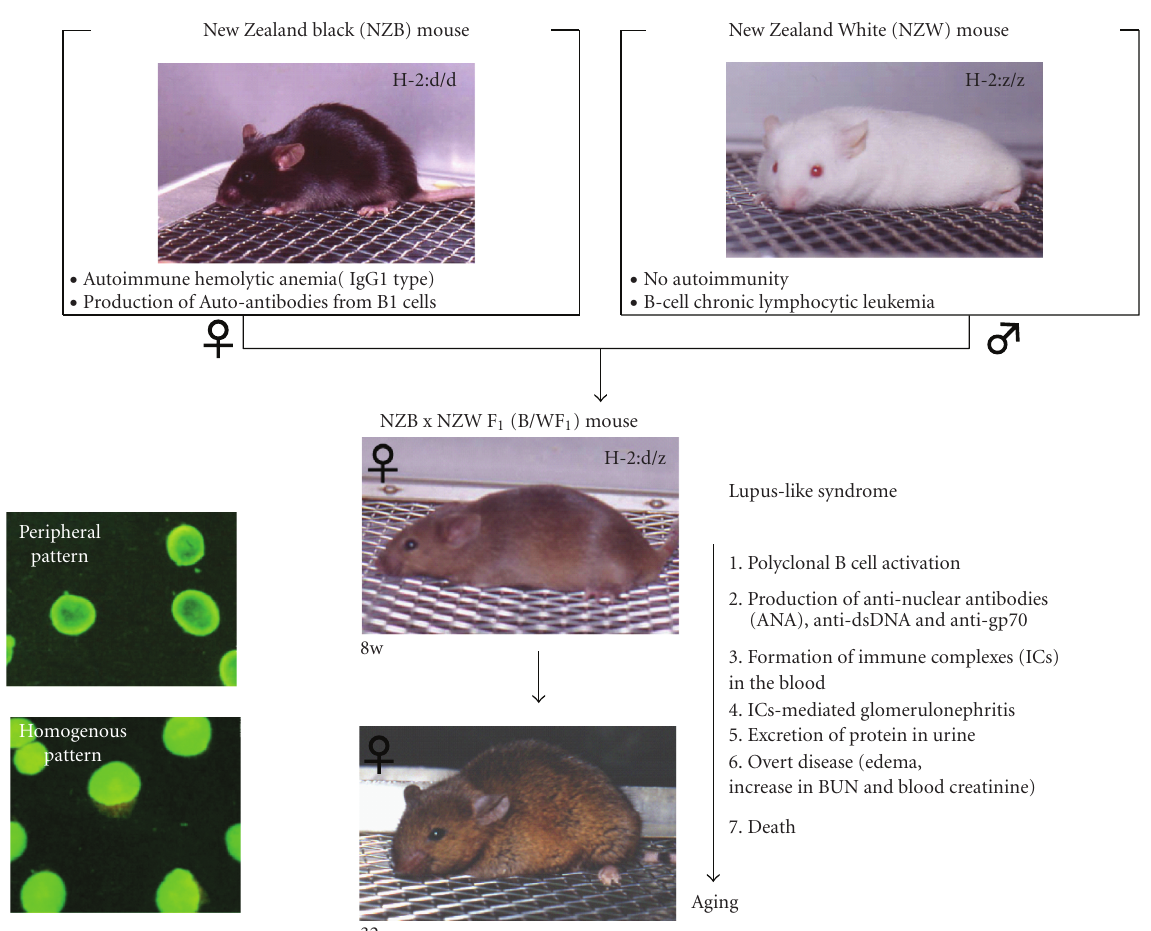
Figure 3: Female B/WF 1 mice constitute one of the best-studied animal models of spontaneous systemic lupus erythematosus (SLE) in human. Their characteristic features include polyclonal B-cell activation, production of autoantibodies against autoantigens (e.g., notably dsDNA), which occur when the animals are 5-6 months of age, and development of glomerulonephritis with age which is the major cause of death due to renal failure. Moreover, animals respond to cortisone similar to human patients with SLE [51]. H-2: mouse MHC. ANA: antinuclear